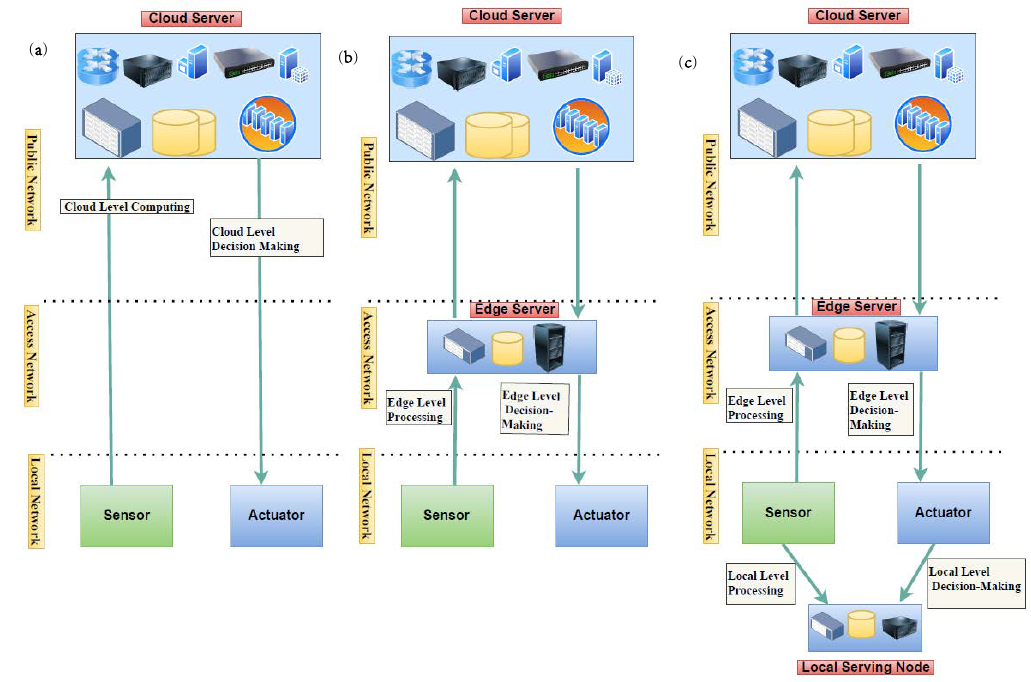
Figure 1. Existing IoT models: ( a ) cloud IoT model; ( b ) edge-cloud IoT model; ( c ) local edge-cloud IoT